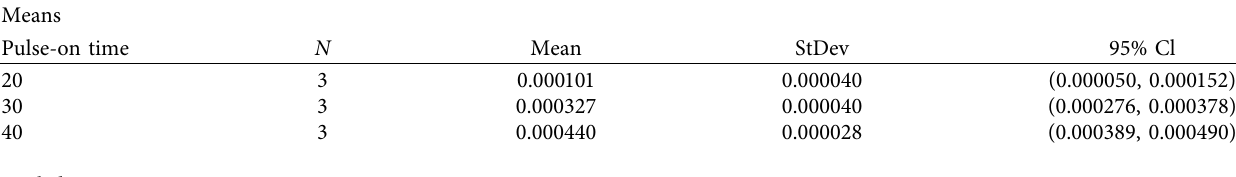
Table 16: The mean and standard deviation in mild steel for different pulse-on